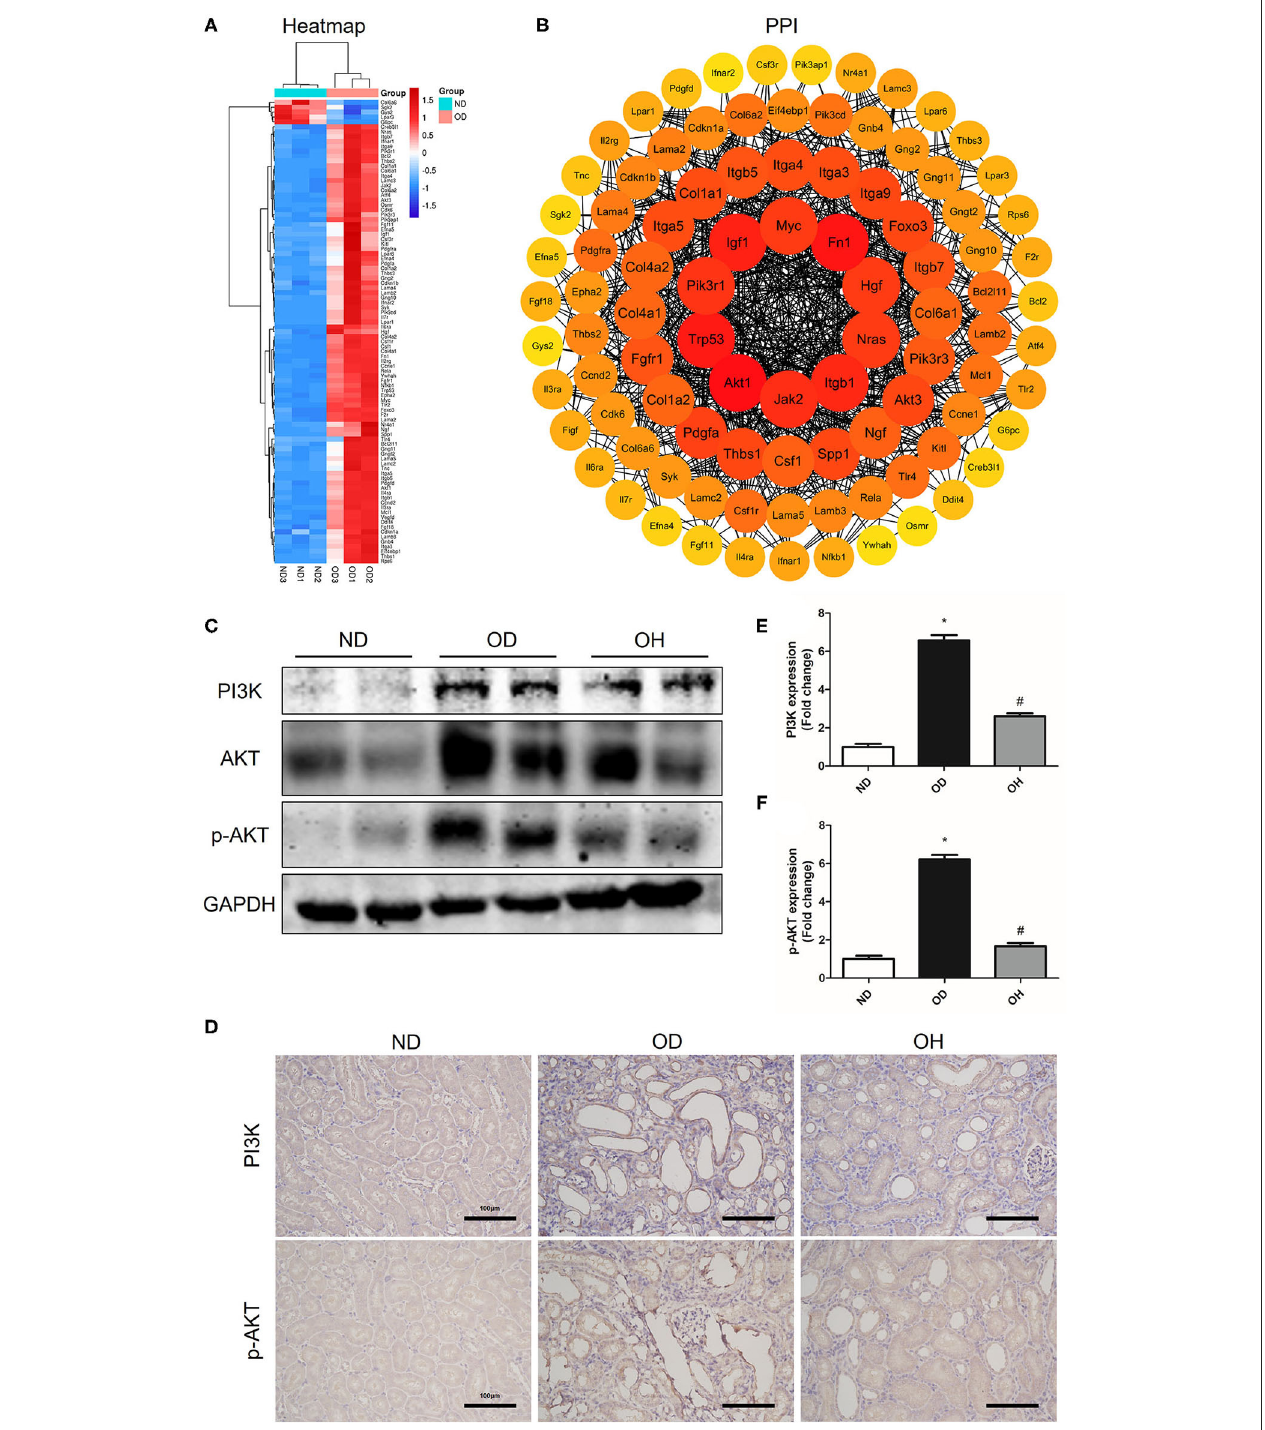
FIGURE 5 | HRW administration suppresses oxalate-induced PI3K/AKT signaling pathway activation in mice. (A) Heatmap and hierarchical clustering showing DEGs enriched in the PI3K/AKT signaling pathway between the OD and ND groups. (B) PPI network constructed by DEGs enriched in the PI3K/AKT signaling pathway. (C) The protein expressions of PI3K, AKT, and p-AKT in kidneys of mice were detected by western blotting. (D) The protein expressions of PI3K and p-AKT in kidneys of mice were detected by immunohistochemistry (Scale bar = 100 µ m). (E,F) Corresponding semiquantitative analysis of PI3K and p-AKT immunohistochemistry staining. The results were expressed as mean ± SEM. Statistical comparisons were performed using a NewmanKeuls test (* p < 0.05 vs. ND group, # p < 0.05 vs. OD group).